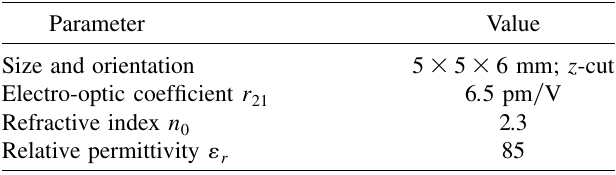
TABLE II. Characteristics of lithium niobate crystal [18].